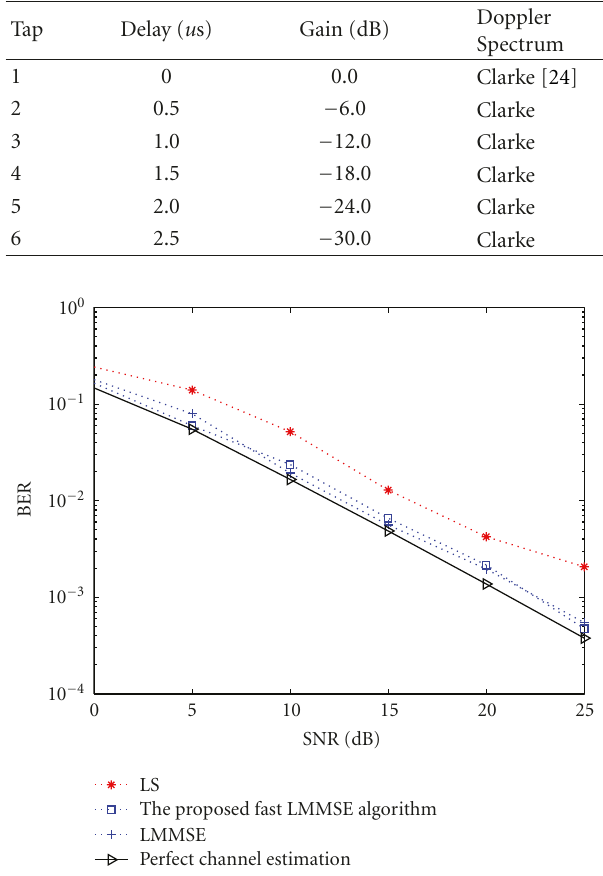
Table 1: Channel Power Intensity Profile.